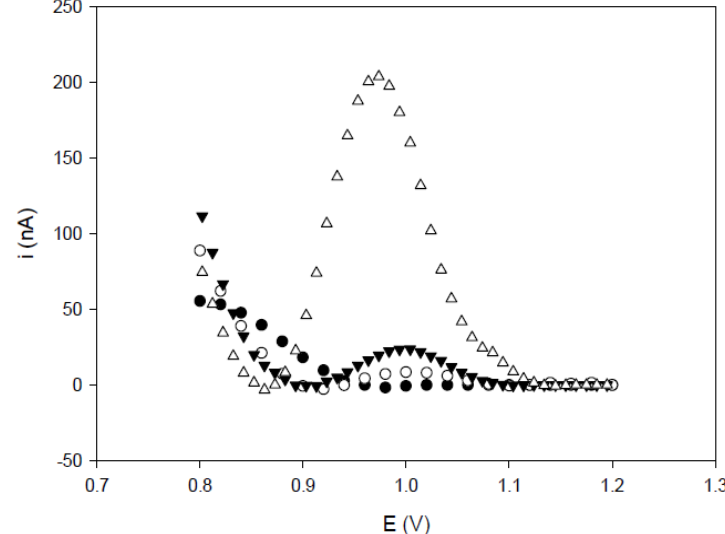
Figure 1. The differential pulse voltammograms of guanine oxidation on (●) non-activated PGE, (○) activated PGE, (▼) TSF-1P (1 µM) immobilized on non-activated PGE and (∆) TSF-1P (1 µM) immobilized on activated PGE. Voltammetric conditions: